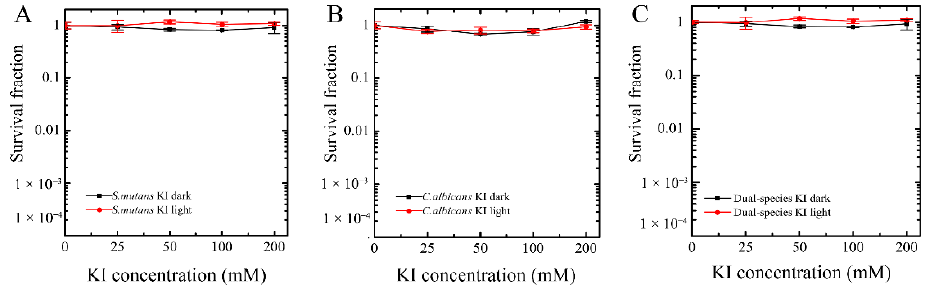
Figure 1. Assessment of dark toxicity and phototoxicity of potassium iodide (KI) on plaque sus- pension. The survival fraction of S. mutans ( A ), C. albicans ( B ), and total microorganisms ( C ) were determined by the counting forming unit (CFU) method.